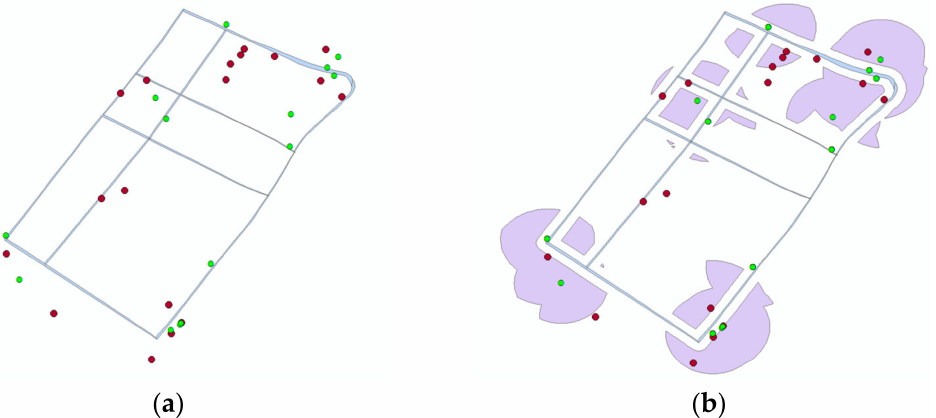
Figure 11. ( a ) Shopping malls, schools, and roads in a specific region; ( b ) appropriate housing selection area in a specific